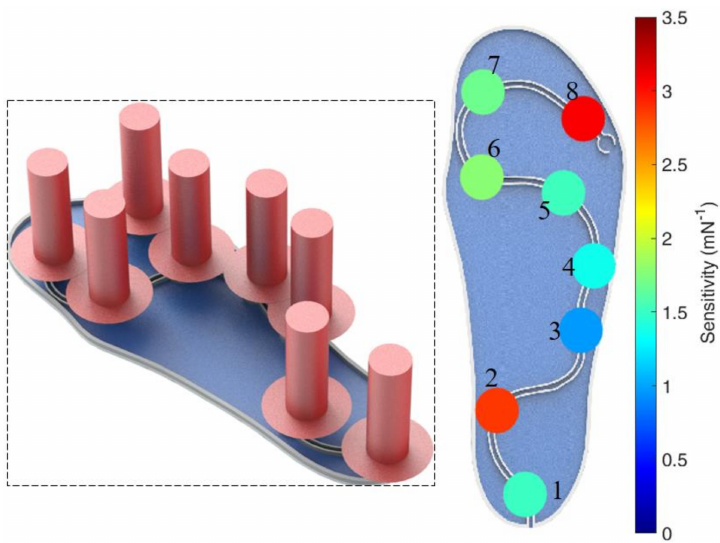
Figure 4. Sensitivity distribution of the POF-instrumented insole. Figure inset shows a schematic representation of the forces positioning in the characterization.